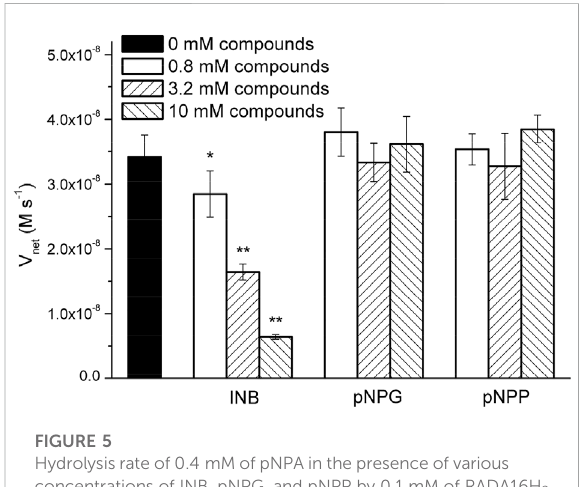
FIGURE 5 Hydrolysis rate of 0.4 mM of pNPA in the presence of various concentrations of INB, pNPG, and pNPP by 0.1 mM of RADA16H 2 at 25 ° C. * p < 0.05, ** p < 0.001 vs. the hydrolysis rate of pNPA without any pNPA-mimicking compound.